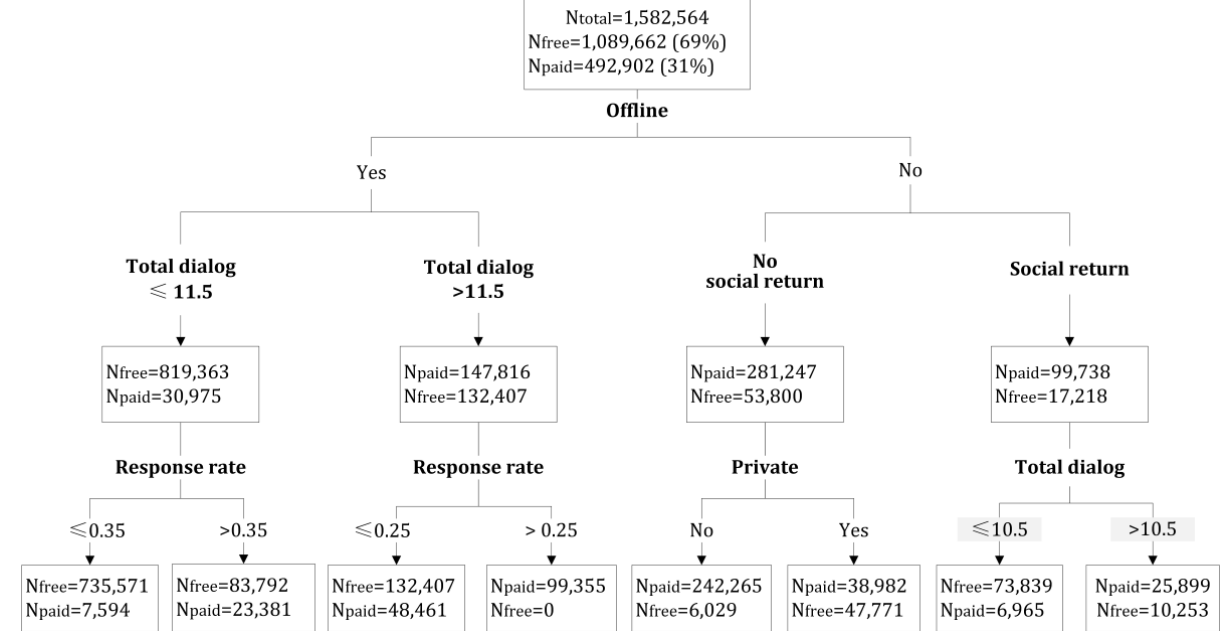
Figure 2. Decision tree for identifying patient subgroups with the full